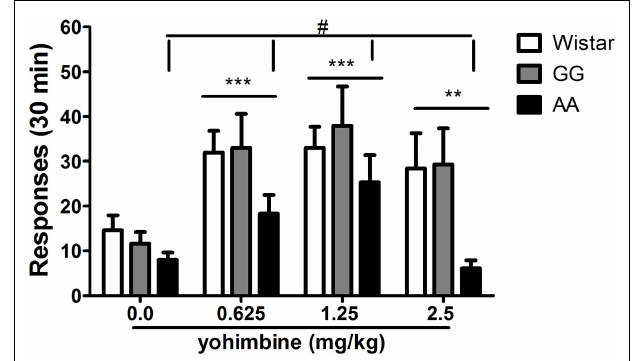
FIGURE 4 | Systemic (i.p.) administration of yohimbine (0.0, 0.625, 1.25, 2.5mg/kg) elicits reinstatement of alcohol seeking inWistar ( n = 7), as well as GG ( n = 8), andAA ( n = 9) msP rats following extinction. The AA msP line shows decreased threshold for yohimbine-induced reinstatement due to different sensitivity on responding to the effects of 2.5mg/kg yohimbine dose. Data are the mean ( ± SEM) of total number of responses in 30min. ** p < 0.01, *** p < 0.001, difference from the vehicle-treated groups (0.0mg/kg); # p ≤ 0.05, difference from the collapsed means of both the GG msP and theWistar lines.Wistar: white bars; GG: gray bars; AA: black bars. For detailed statistics, see